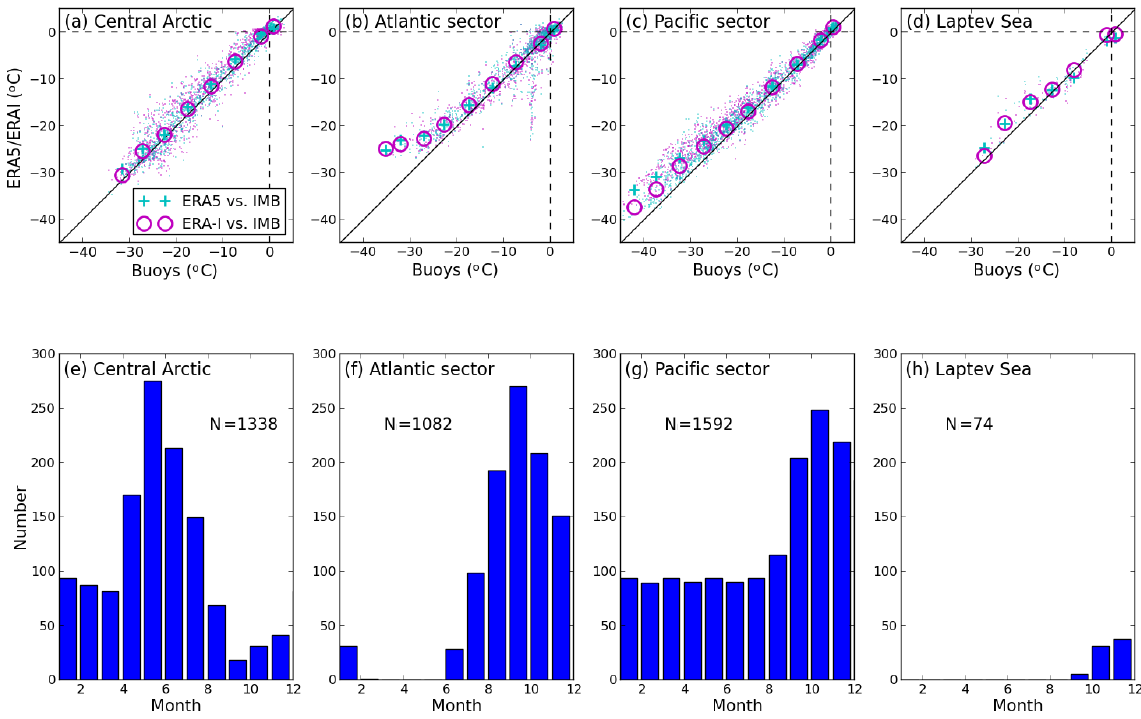
Figure 6. Scatter plot of T2M from ERA5 and ERA-I vs. from buoys for the (a) central Arctic, (b) Atlantic sector, (c) Pacific sector, and (d) Laptev Sea, and number of buoy data (daily) per month for the (e) central Arctic, (f) Atlantic sector, (g) Pacific sector, and (h) Laptev sea. The definition of sectors are shown in Fig.